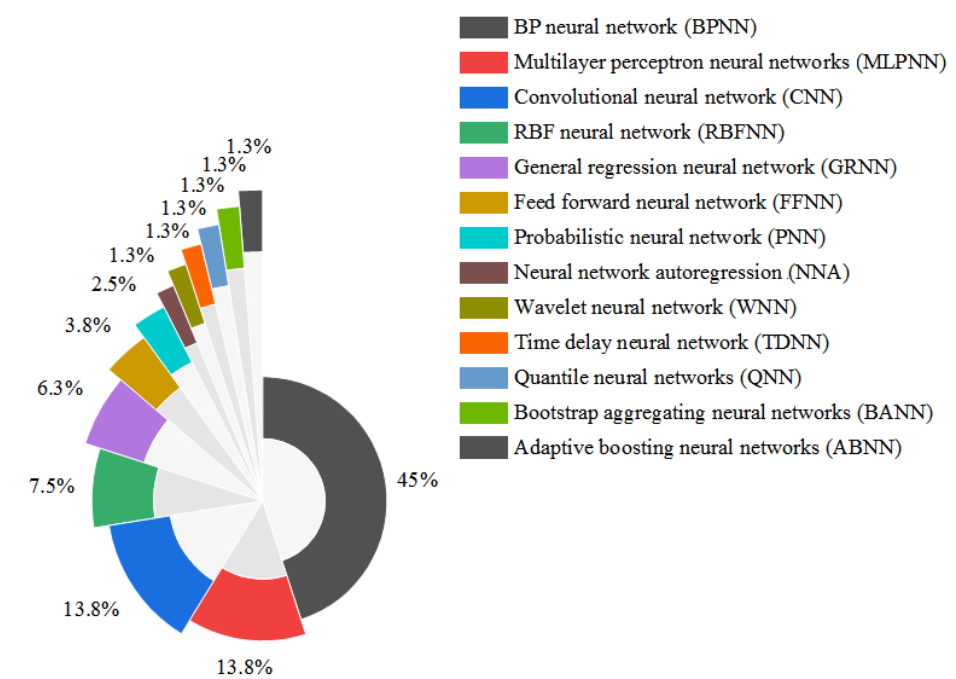
Figure 4. Types of ANNs applied in selected articles.